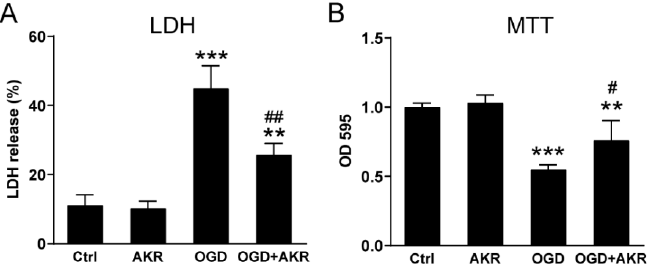
Figure 5. AKR1C15 protected against OGD-induced neuronal death. Primary rat neurons were subjected to 1 h OGD followed by 24 h reoxygenation in the presence or absence of 10 µg/mL TAT-